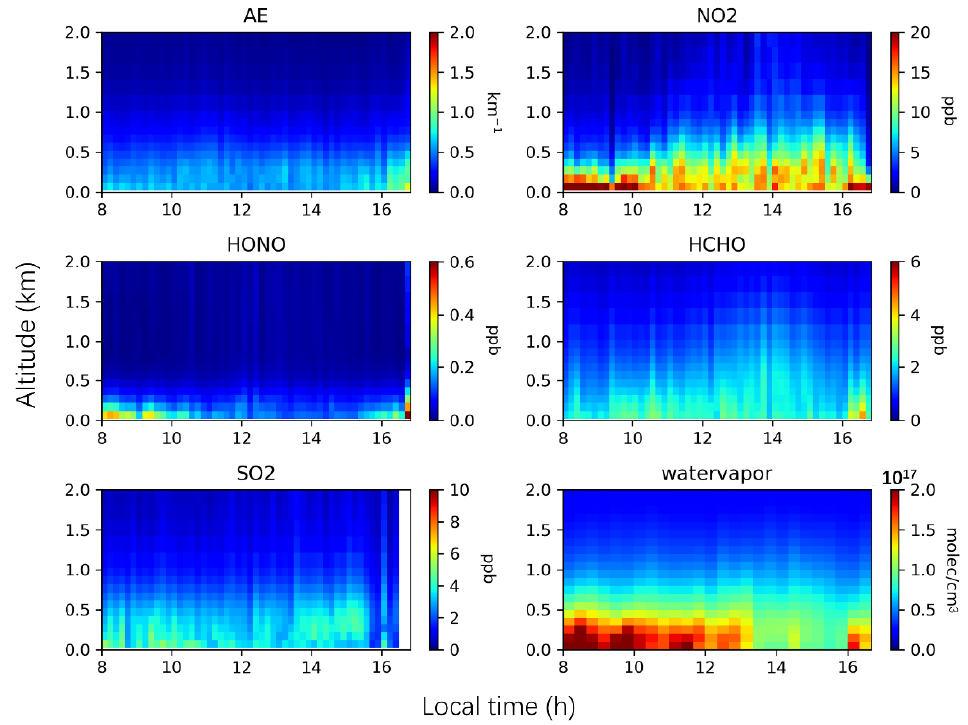
Figure 5. Diurnal variations of the vertical distribution characters of tropospheric aerosol extinction coefficient, and HONO, SO 2 , NO 2 , HCHO, and water vapor vertical mixing ratios during clear days.